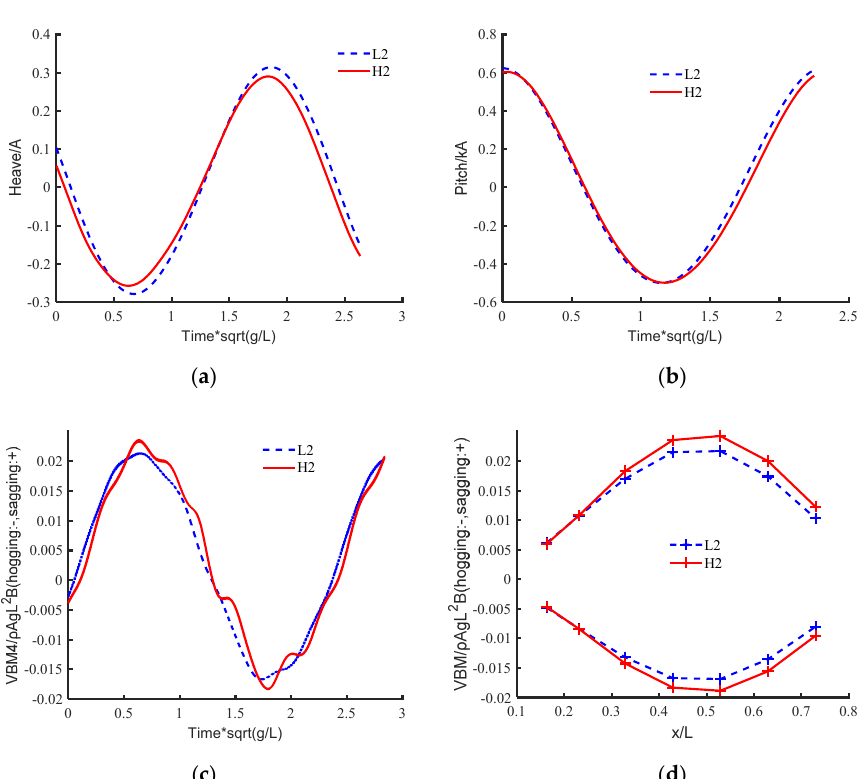
Figure 15. Comparison of structural response between L2 and H2. ( a ) time series of Heave; ( b ) time series of Pitch; ( c ) time series of VBM4; ( d ) VBM at seven sections.